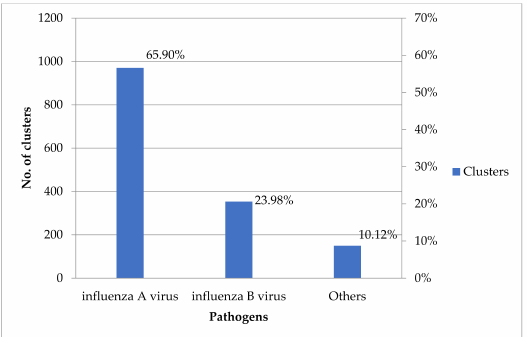
Figure 1. The number and percentage of influenza viruses and other pathogens among URTI clusters, Taiwan, 2011–2019. URTI: upper respiratory tract